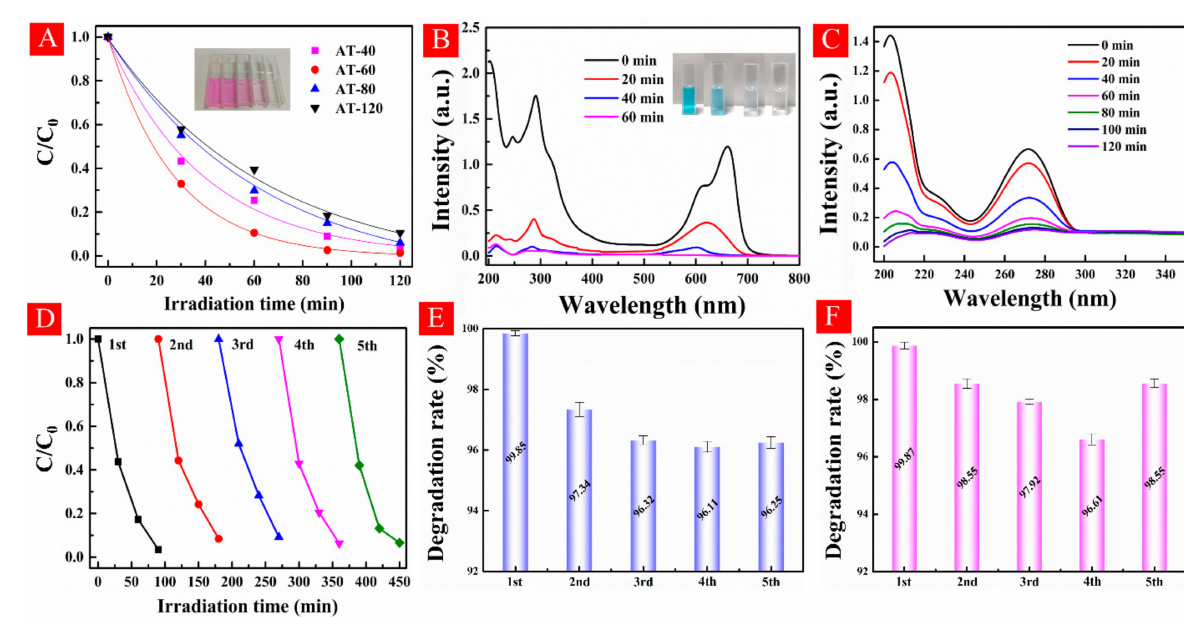
Figure 8. ( A – C ) are the visible-light photodegradation of RhB, MB, and theophylline, respectively. ( D – F ) are the recycling experiments of RhB, MB, and theophylline,